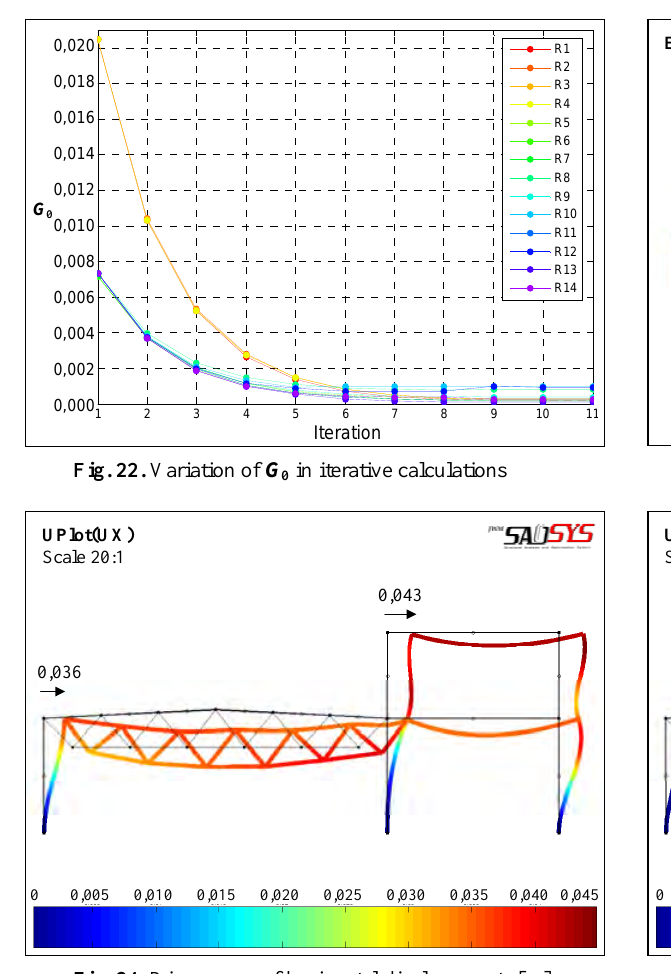
Fig. 24. Diagram u X of horizontal displacements [m] Fig. 25. Diagram u Y of vertical displacements